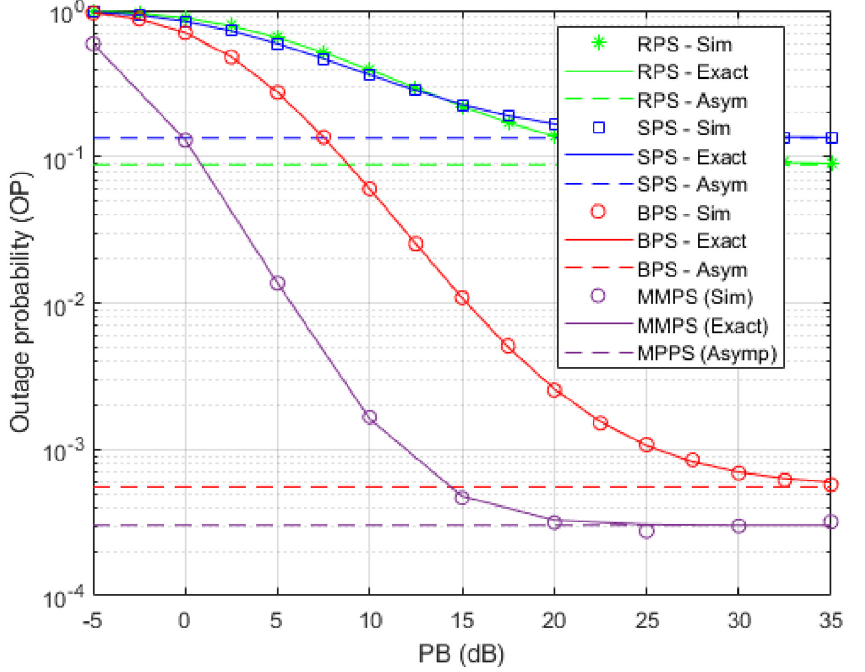
Fig 3. OP as a function of transmitting power P in